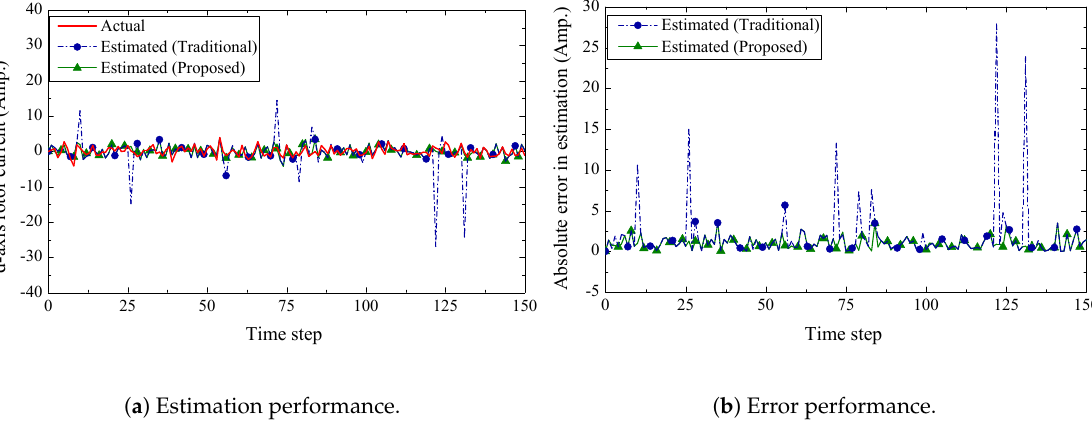
Figure 7. d-axis rotor current estimation and error performance.